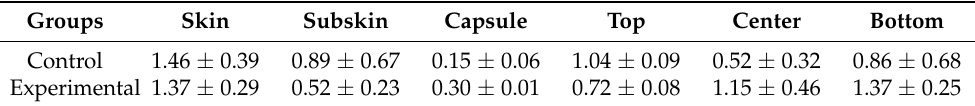
Table 1. The thicknesses (mean ± sd, mm) of the samples from experimental and control groups. Groups Skin Subskin Capsule Top Center Bottom Control 1.46 ± 0.39 Experimental 1.37 ± 0.29 0.52 ±